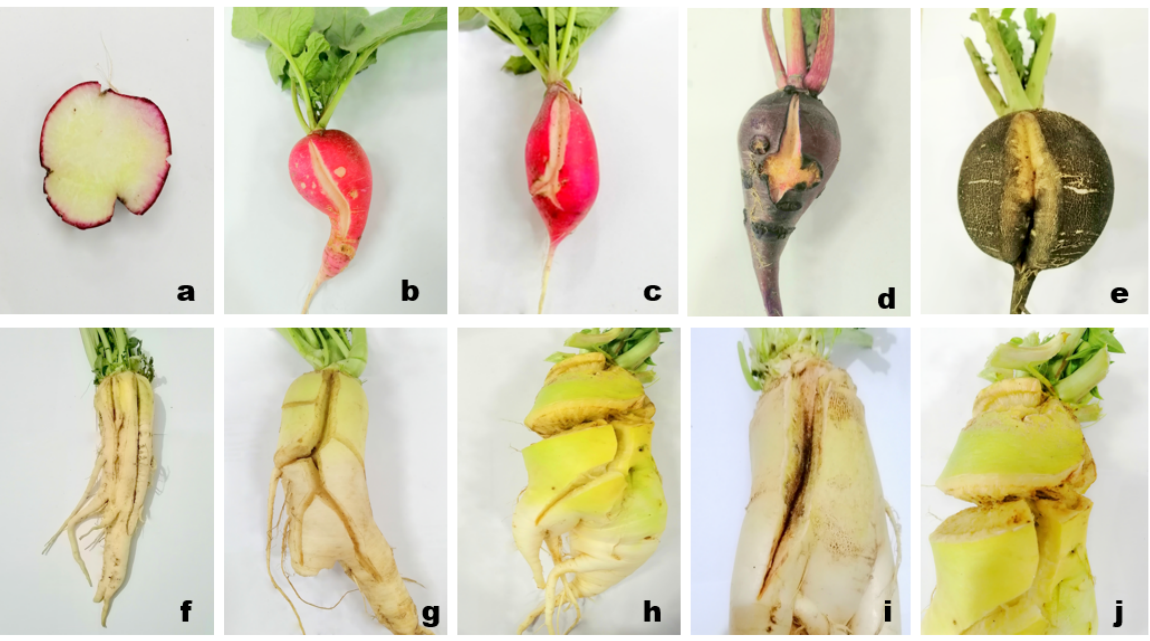
Figure 4. Cracking/splitting disorder in different radish cultivars: cross section of cracked roots (( a ): Bari Red) moderate splitting: single longitudinal crack (( b , c ): Belly red, ( d , e ): (Black ball)), severe splitting: 2–4 cracks on a single root (( f – h ): Green neck), close view of cracked section showing fungal infection initiation: blackish growth (( i ): Minowase, ( j ): Green neck).